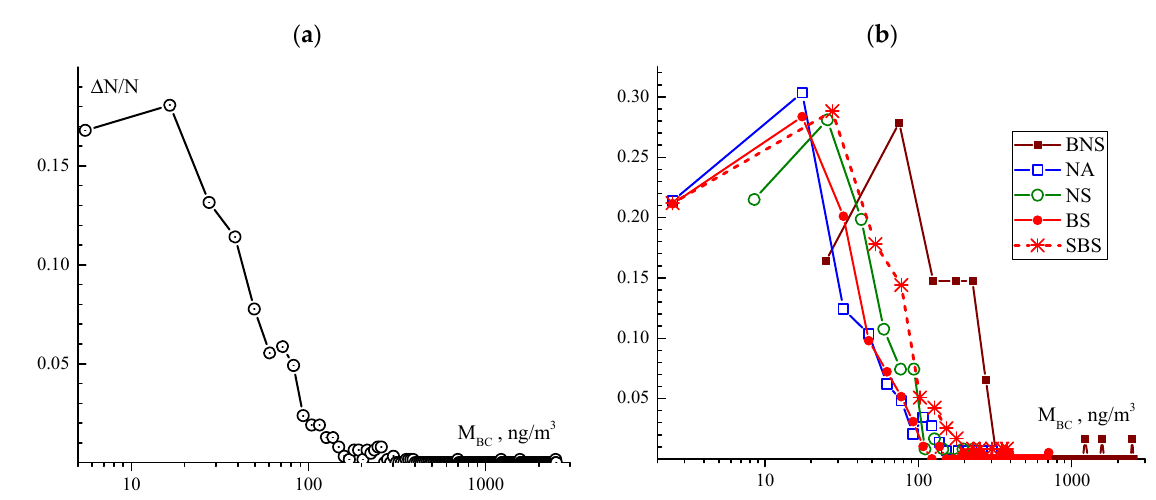
Figure 6. Histograms of repeatability of M BC values in the total data set ( a ) and in individual regions ( b ). Table 3. Statistical characteristics of M BC (ng/m 3 ) in different